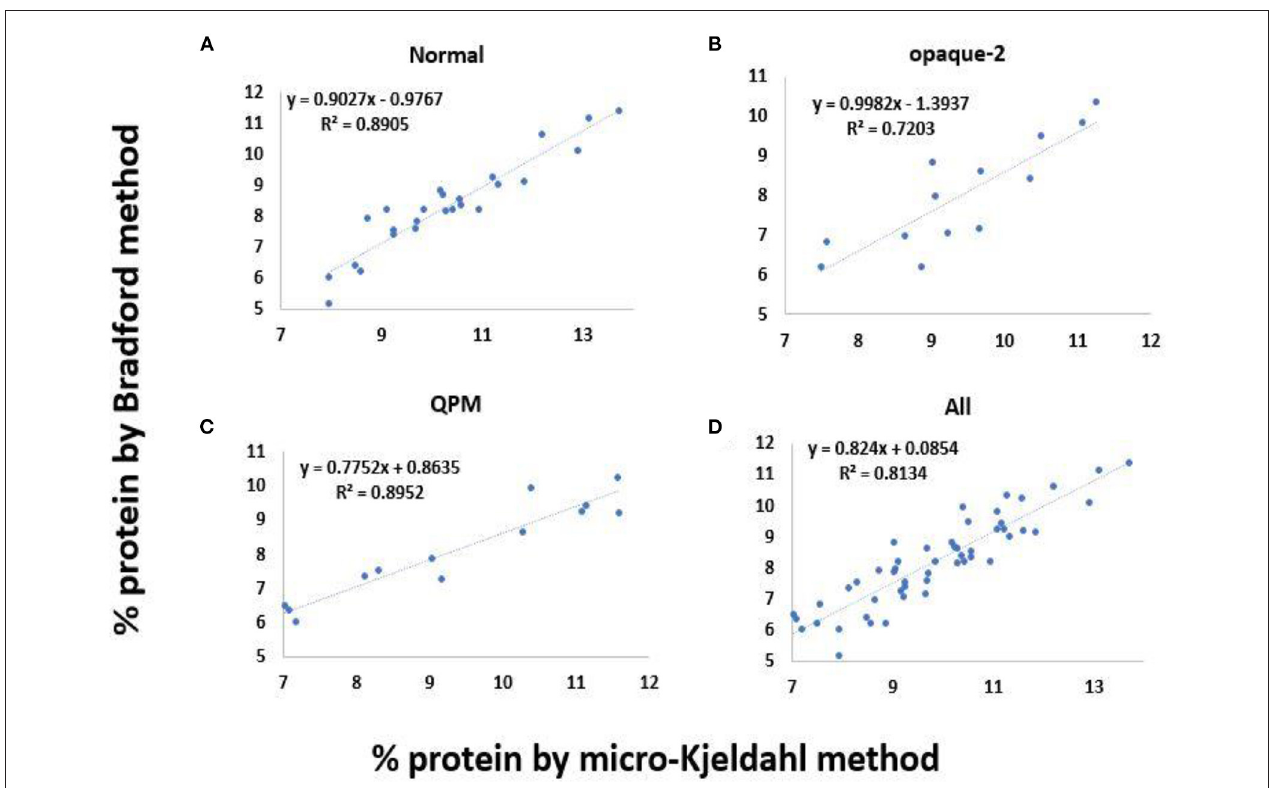
FIGURE 5 | Correlation between protein content estimated by micro-Kjeldahl and Bradford methods. (A) Normal maize genotypes (sample size = 25), (B) opaque-2 maize genotypes (sample size = 13), (C) QPM genotypes (sample size = 13), and (D) Composite of above three samples (sample size = 51).